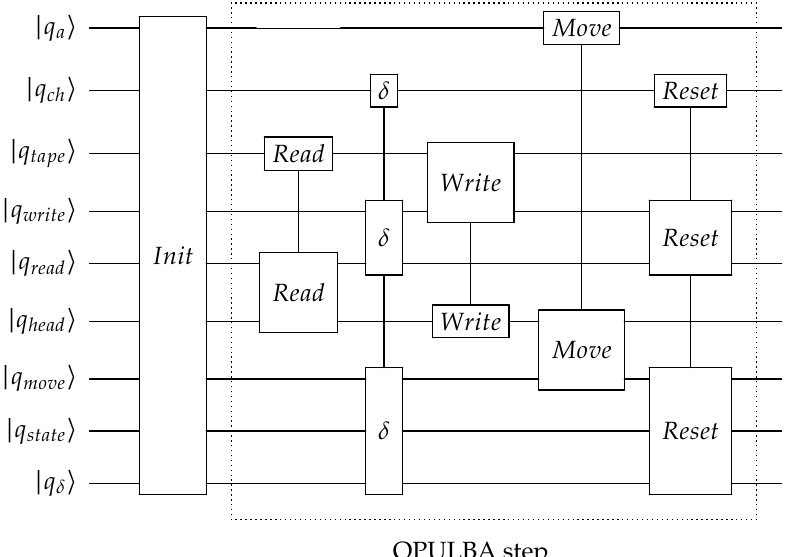
Figure 4. Blocks for the quantum circuit implementation of a QPULBA